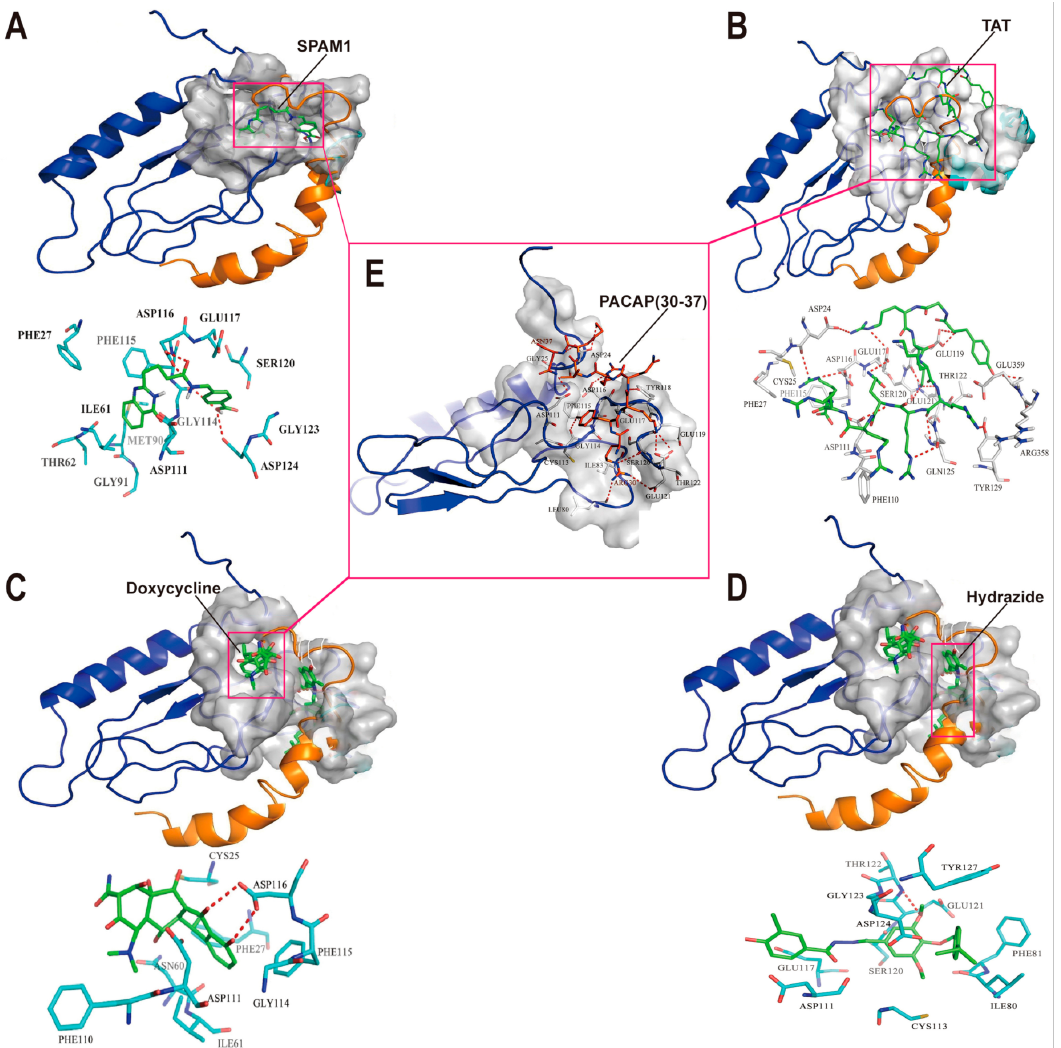
Figure 1. The predicted molecular docking of SPAM1, TAT, DOX, and Hydrazide on PAC1-R and their binding sites compared with PACAP(30–37). ( A ) The upper showed the predicted binding site of SPAM1 on PAC1-R represented by the surface model and the lower showed the details of the predicted binding mode; ( B ) the upper showed the predicted binding site of TAT on PAC1-R represented by the surface model and the lower showed the details of the predicted binding mode; ( C ) the upper showed the predicted binding site of DOX on PAC1-R represented by the surface model and the lower showed the details of the predicted binding mode; ( D ) the upper showed the predicted binding site of hydrazide on PAC1-R represented by the surface model and the lower showed the details of the predicted binding mode; ( E ) PAC1-R with PACAP(30–37) superimposed according to the resolved complex 3D structure of PACAP38 with the extracellular domain of PAC1-R (PDB ID: 2JOD). All the binding sites are represented by the surface model. PAC1-R in deep blue and PACAP38 in yellow are shown in cartoon style, and the binding small molecules are shown as sticks. All the contact residues are shown and labeled by type and number, and the red dotted line illustrated the hydrogen bond interaction. The middle frame indicated that SPAM1, TAT, and DOX shared a similar binding site recognized by